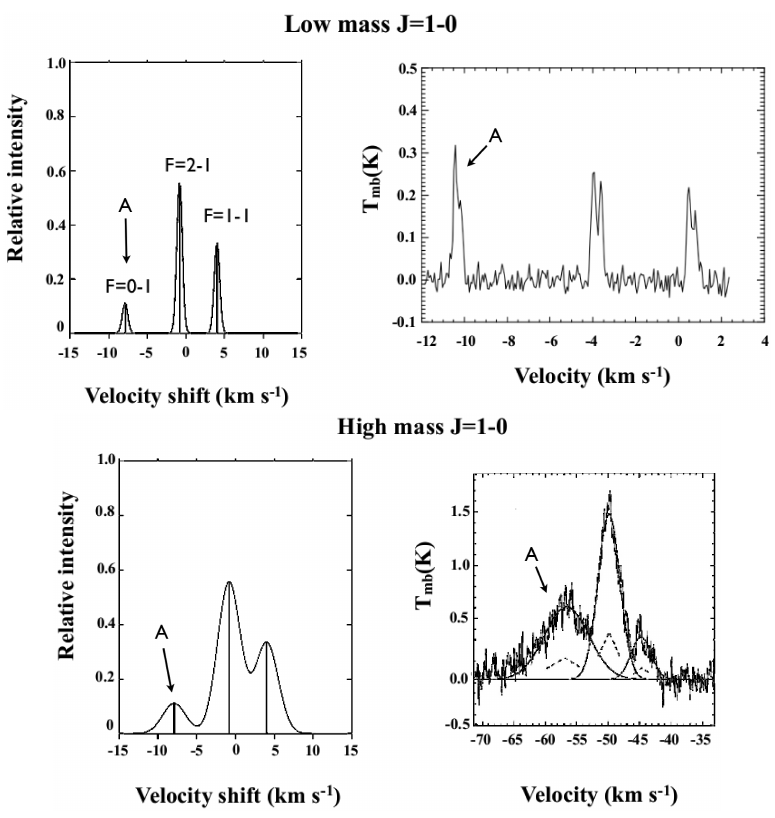
Fig. 1. Top left panel . Optically thin HCN J = 1 ! 0 for a low mass quiescent cloud core. Top right panel . TRAO observation of low mass protostellar core, L1197. Bottom left panel . Optically thin HCN J = 1 ! 0 for high mass turbulent cloud core. Bottom right panel . Mopra observation of high mass core in the G 333-6.02 molecular